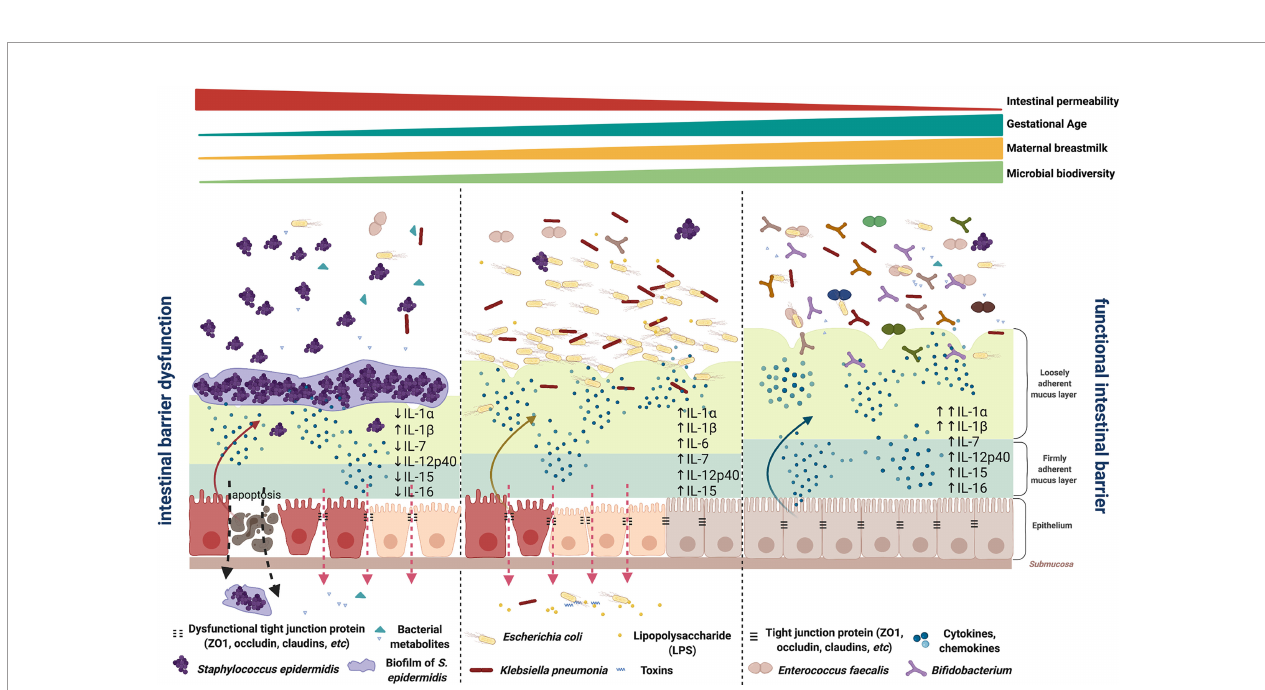
FIGURE 5 | Illustration of the intestinal barrier maturation in early preterm neonates with different microbiota types and cytokine pro fi les. An immature, compromised gut barrier may render the mucosa susceptible to invasion by opportunistic pathogens in the gut lumen. IP was linked with a microbial community dominated by a single species S. epidermidis , K. pneumoniae , or E. coli , with less de fi ned cytokine pro fi les among individuals. A functional intestinal barrier was associated with neonates with later GA; higher BW; greater microbial community biodiversity that encompasses a wide array of anaerobic and facultative microorganisms not dominated by S. epidermidis , K. pneumoniae , or E. coli ; and a trend of increased levels of IL-1 a / b , IL-7, IL-12p40, IL-15, and IL-16. Schematic representation illustrates the distal intestine (not drawn to scale). Created with